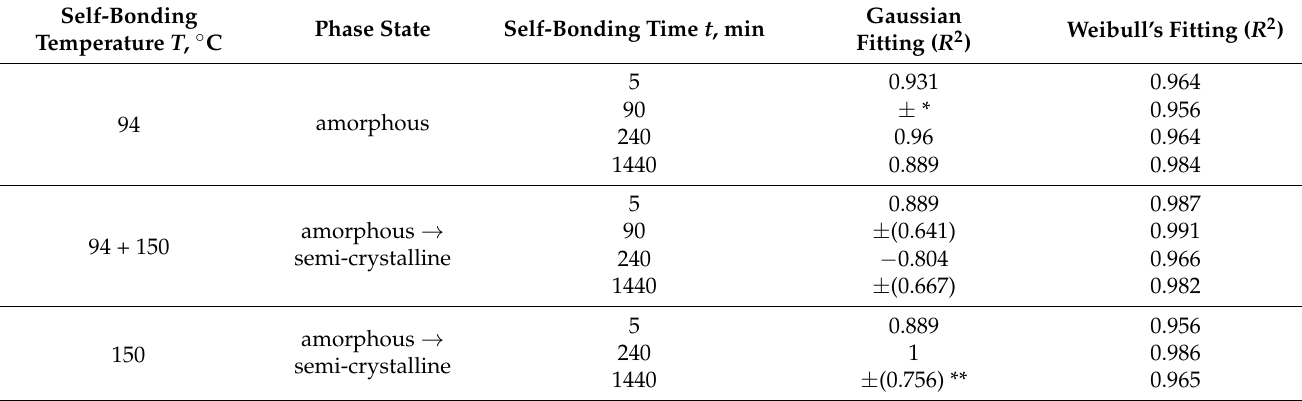
Table 5. Conformity of the lap shear strength distributions of PET–PET interfaces to Weibull’s and Gaussian